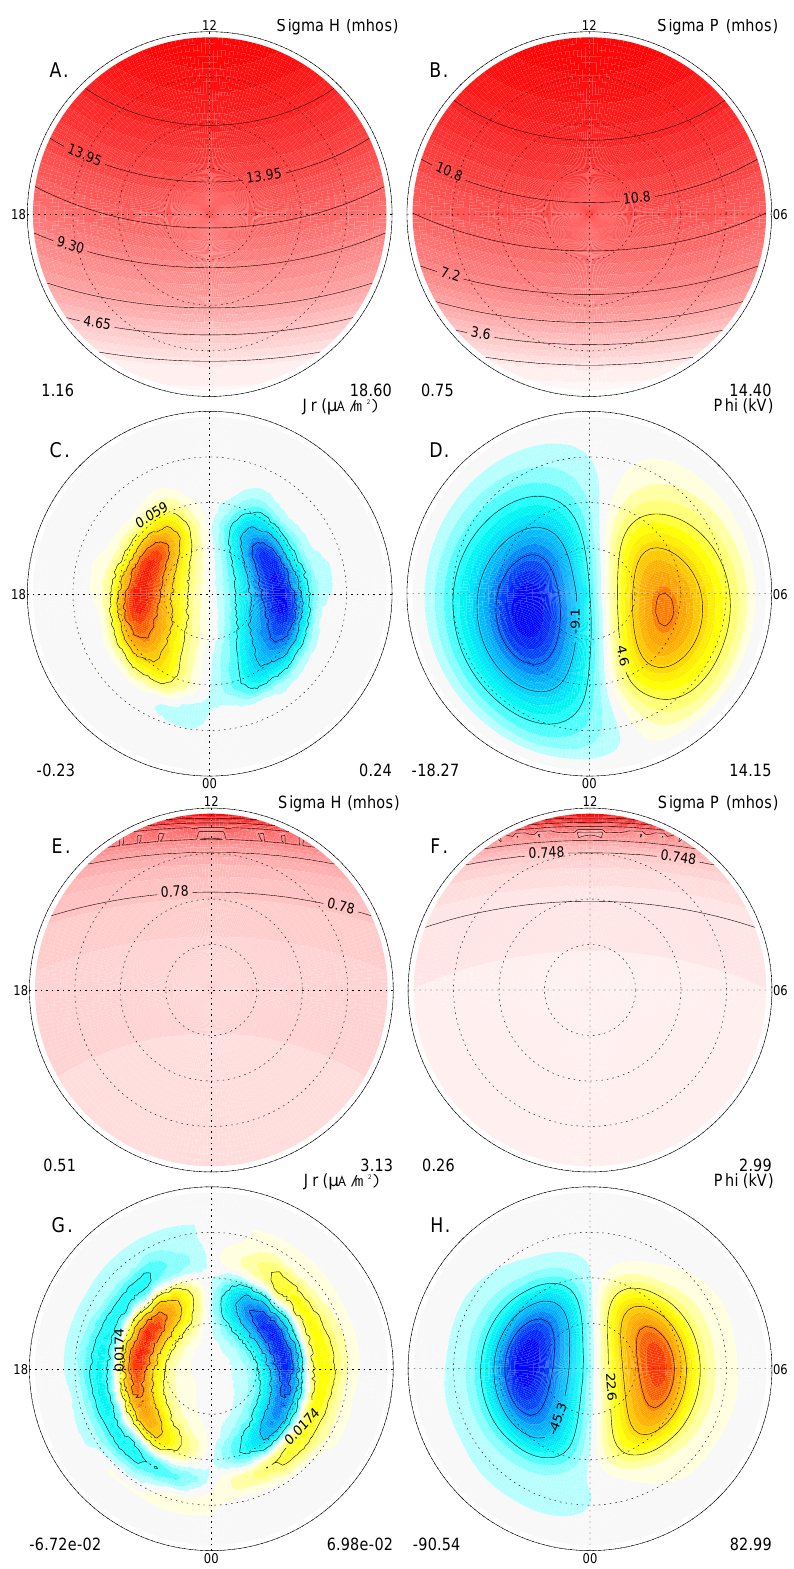
Plate 8. Ionospheric results for summer (A–D) and winter conditions (E–H) , corresponding to Plate 7. This figure is in the same format as Plate